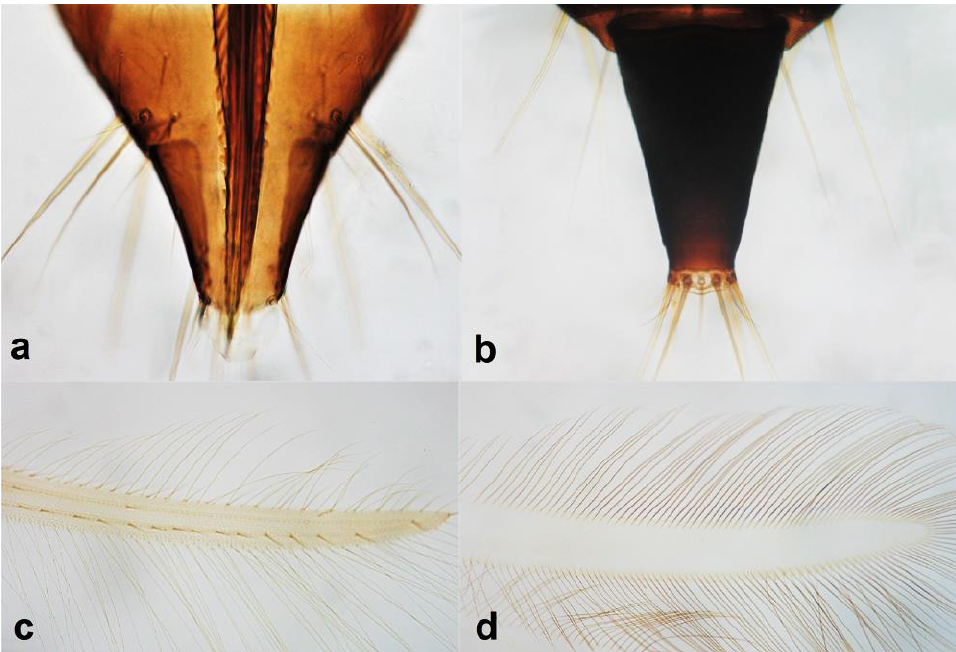
Figure 2. Abdominal segment X ( a , b ): ( a ) conical; ( b ) tubular ; fore wing ( c , d ): ( c ) with longitudinal veins; ( d ) with no veins.